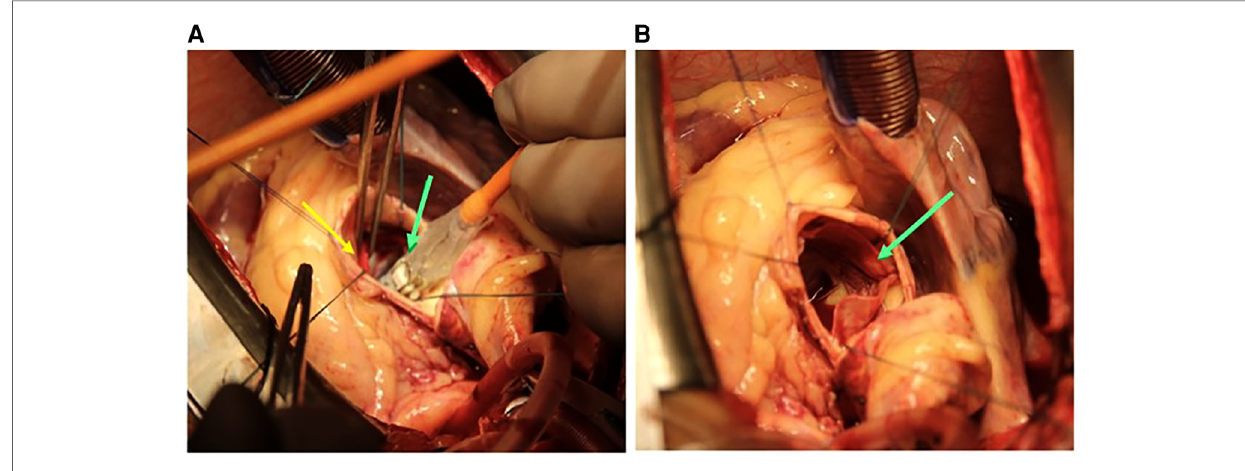
FIGURE 3 ( A ) Deployment of the 30.5 mm Myval THV (green arrow) positioning into the ring (yellow arrow). ( B ) Deployed THV (green arrow). THV, transcatheter heart valve.